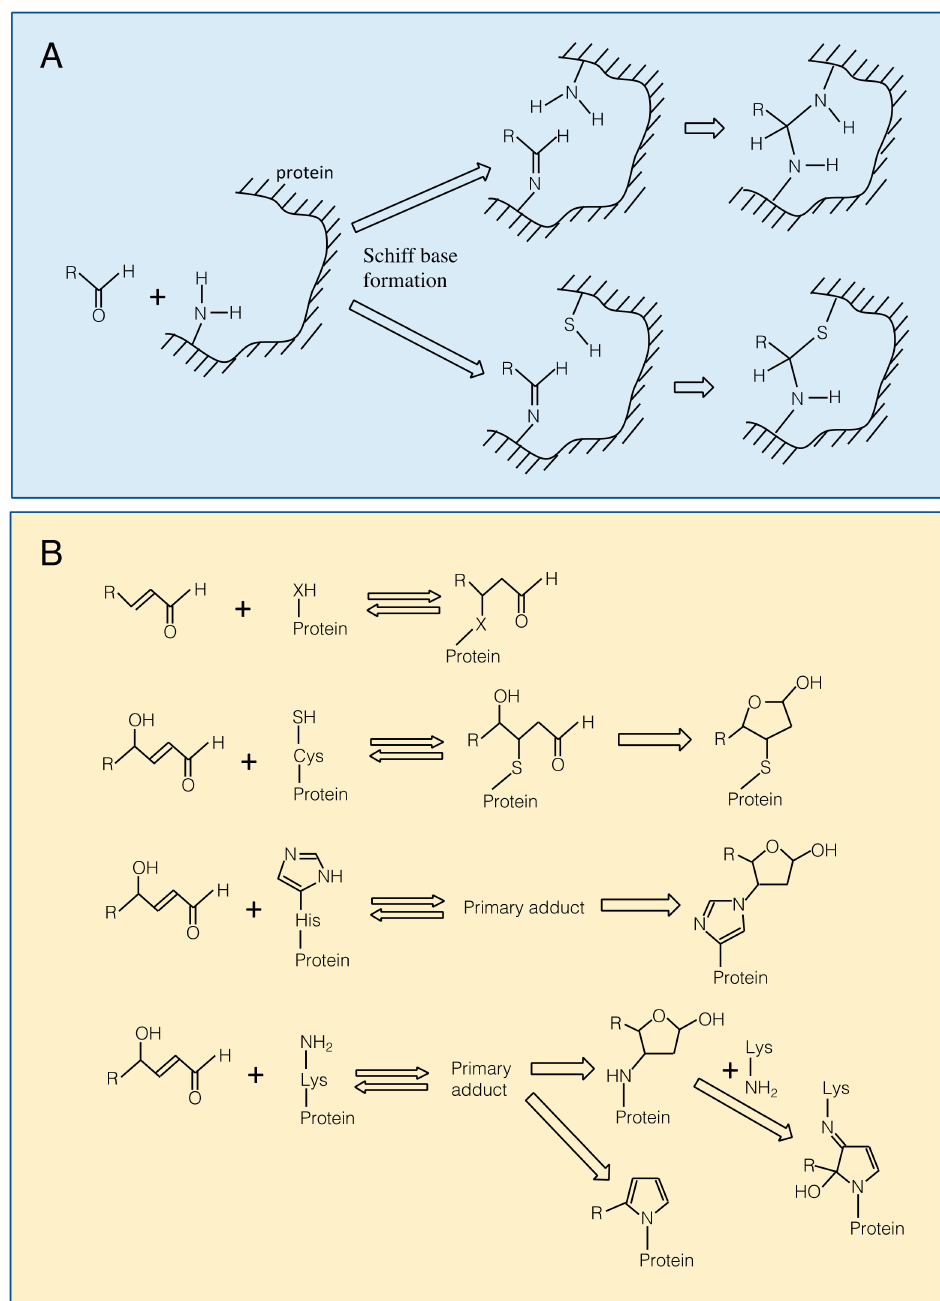
Figure3. Modificationofaminoacidresiduesonaproteinwithcarbonyls. PanelA .Schi ff